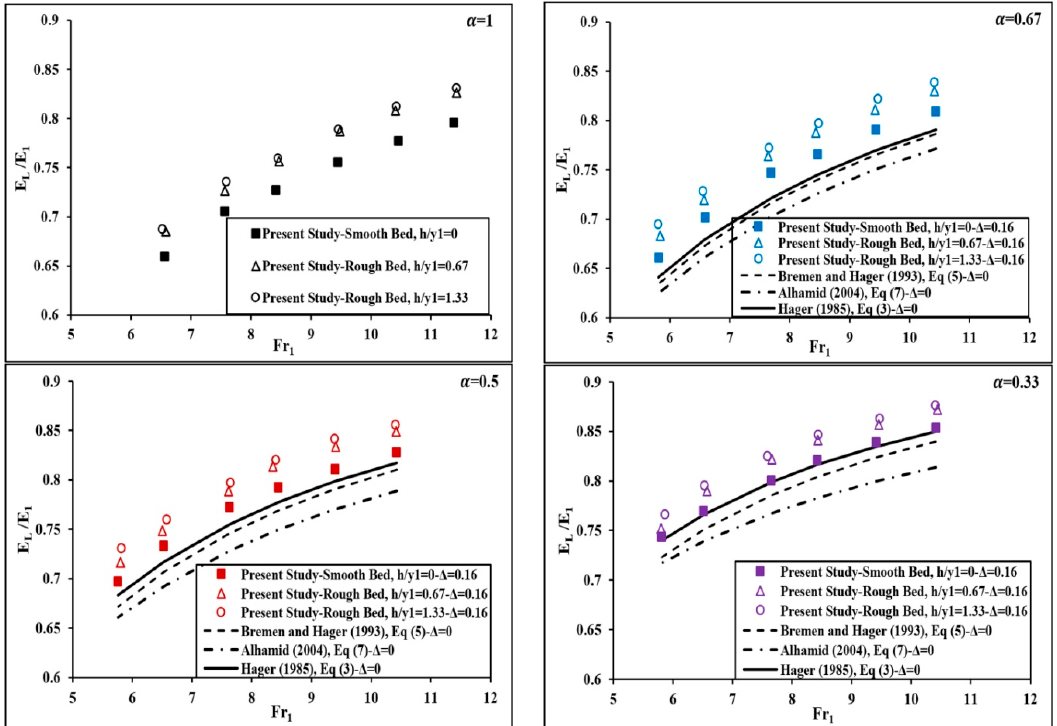
Figure 19. Relative energy loss of the hydraulic jump as a function of upstream Froude number for two relative roughness heights ( h / y 1 = 0.67 and 1.33) and di ff erent expansion ratios ( α = 0.33, 0.5, 0.67, 1) with asymmetry ratio of ∆ = 0.16.